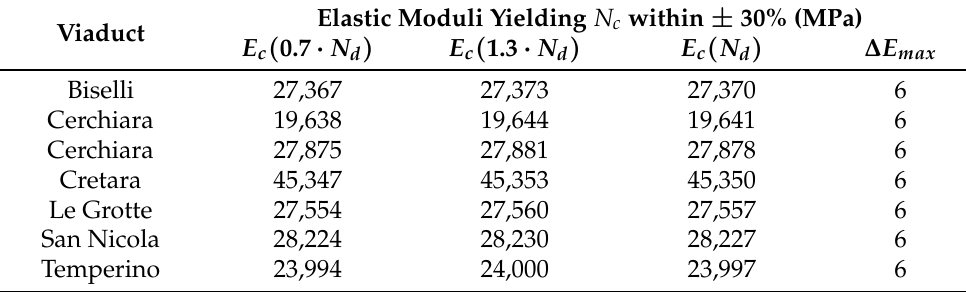
Table 3. Elastic moduli associated with the design prestressing N d = 29,000 kN.